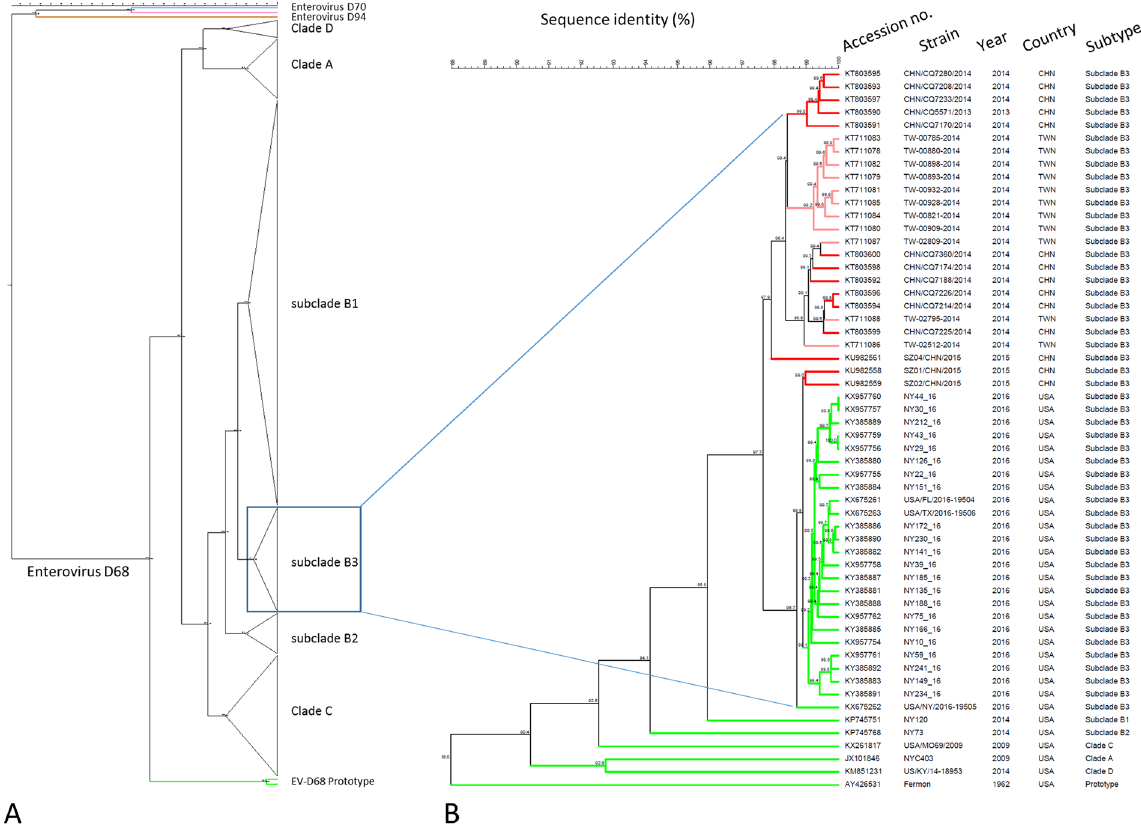
Figure 3. ( A ) Collapsed phylogenetic tree of enterovirus D68 based on nucleotide sequences of 341 complete or nearly complete genomes. Please refer to supplemental Figure S1 for a detailes phylogenetic tree with sequence accession numbers and strain information. Strains of EV-D70 and EV-D90 were used as outgroup; ( B ) An enlarged phylogenetic tree of EV-D68 subclade B3 strains (n = 50). Strains from China (CHN) and Taiwan (TWN) were shown in red and pink, respectively, whereas strains from the US were shown in green. One strain representing each of other subtypes (clades A, C and D, subclades B1 and B2, and prototype) was included for comparison. The numbers at each branch node are the % of nucleotide sequence